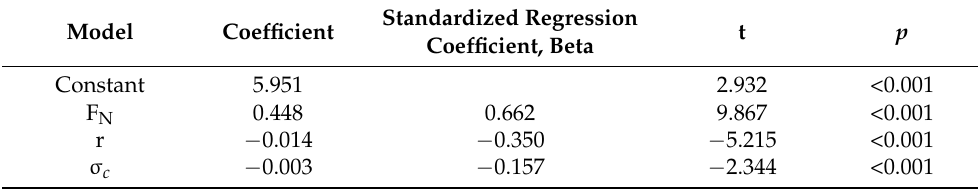
Table 5. Coefficients of the regression model for scratch depth in single-asperity